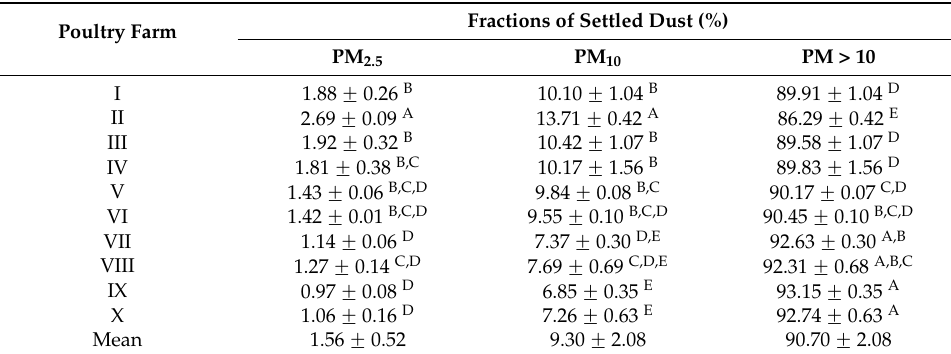
Table 5. Percentage share of granulometric fractions of settled dust. Poultry